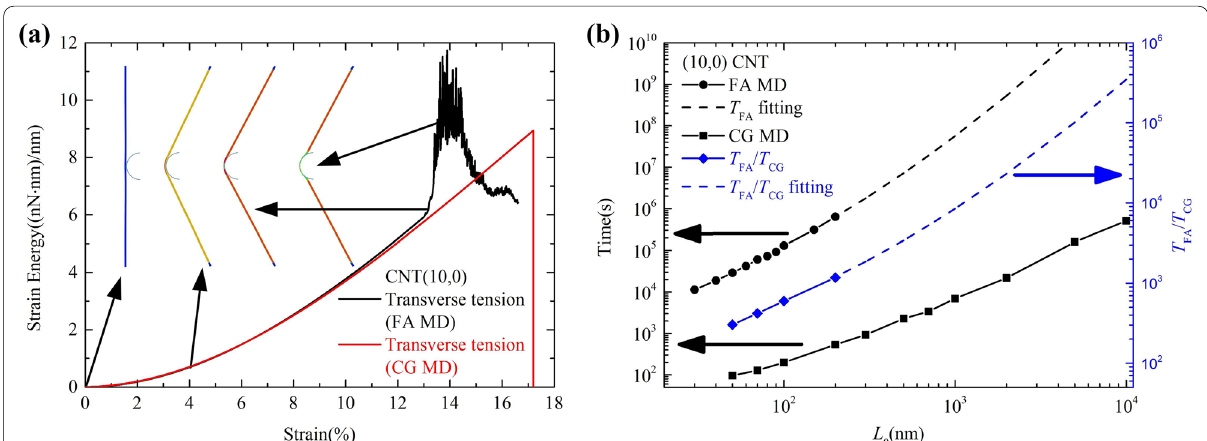
Figure 12 ( a ) Strain energy change of a (10,0) CNT under transverse tension, ( b ) The change of the computational cost of (10,0) CNT with different CNT length L 0 using FA MD and CG MD simulations